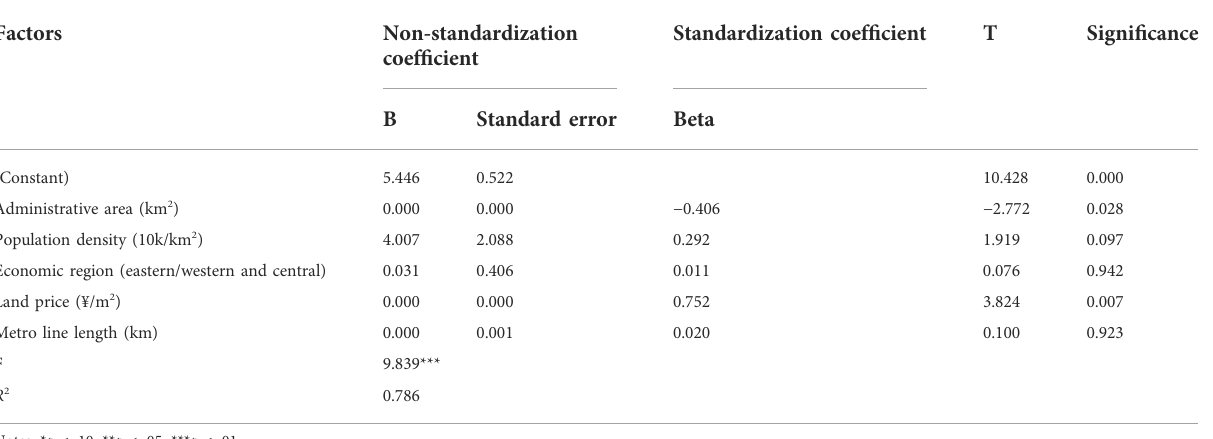
TABLE 1 Construction results of regression model.